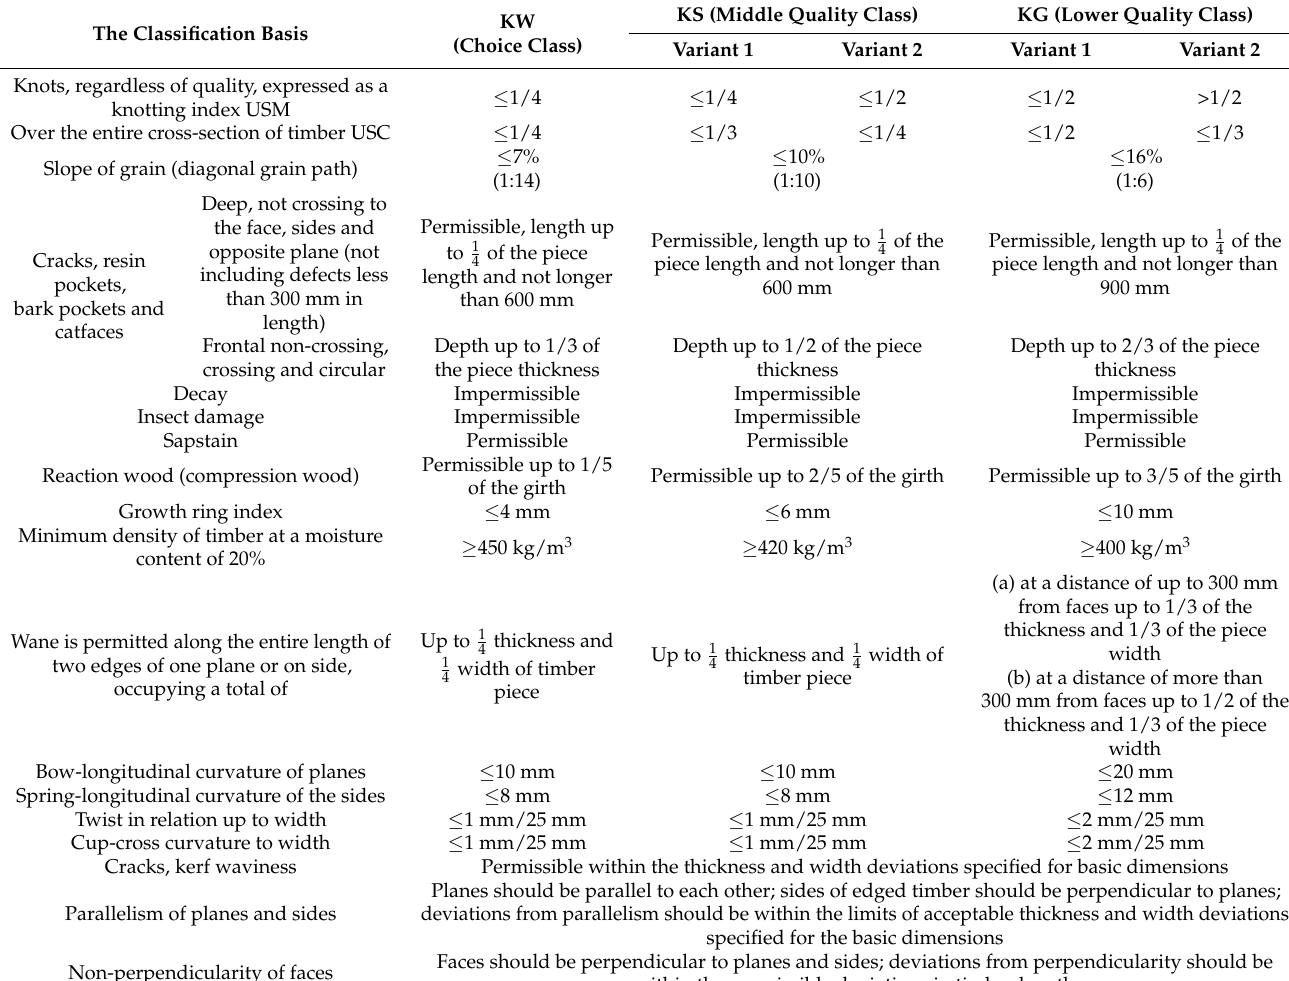
Table 1. The criteria for the visual grading of wood according to the PN-D-94021 [47,48].